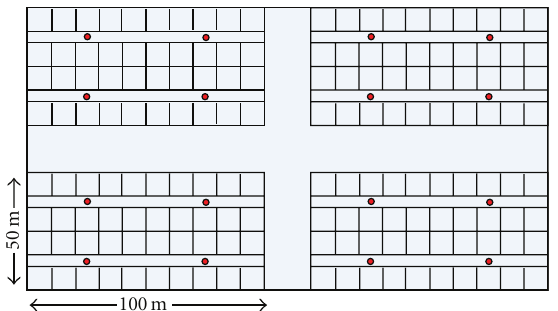
Figure 1: Layout of four-building scenario in the WINNER 2 o ffi ce Manhattan path loss model. Red dots represent pico-cell BSs.